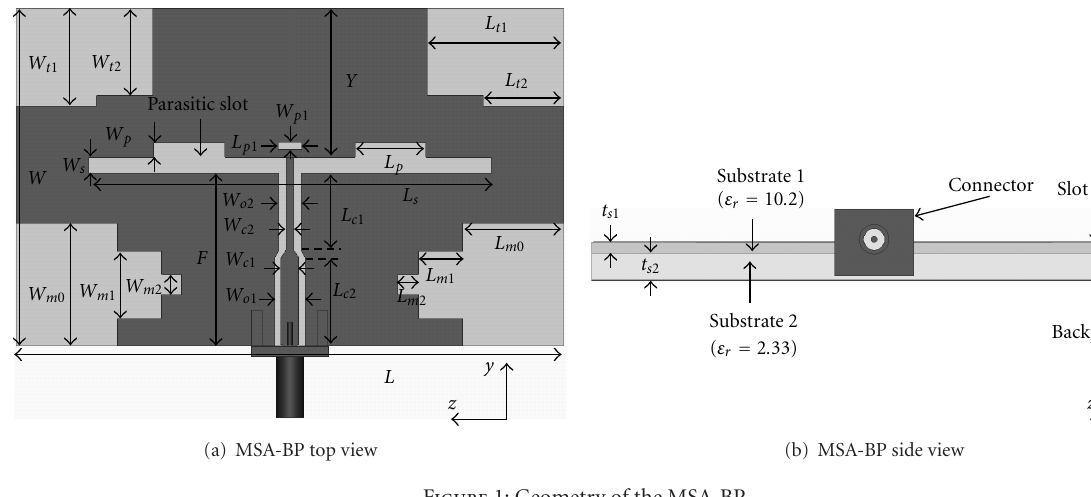
Figure 1: Geometry of the MSA-BP.